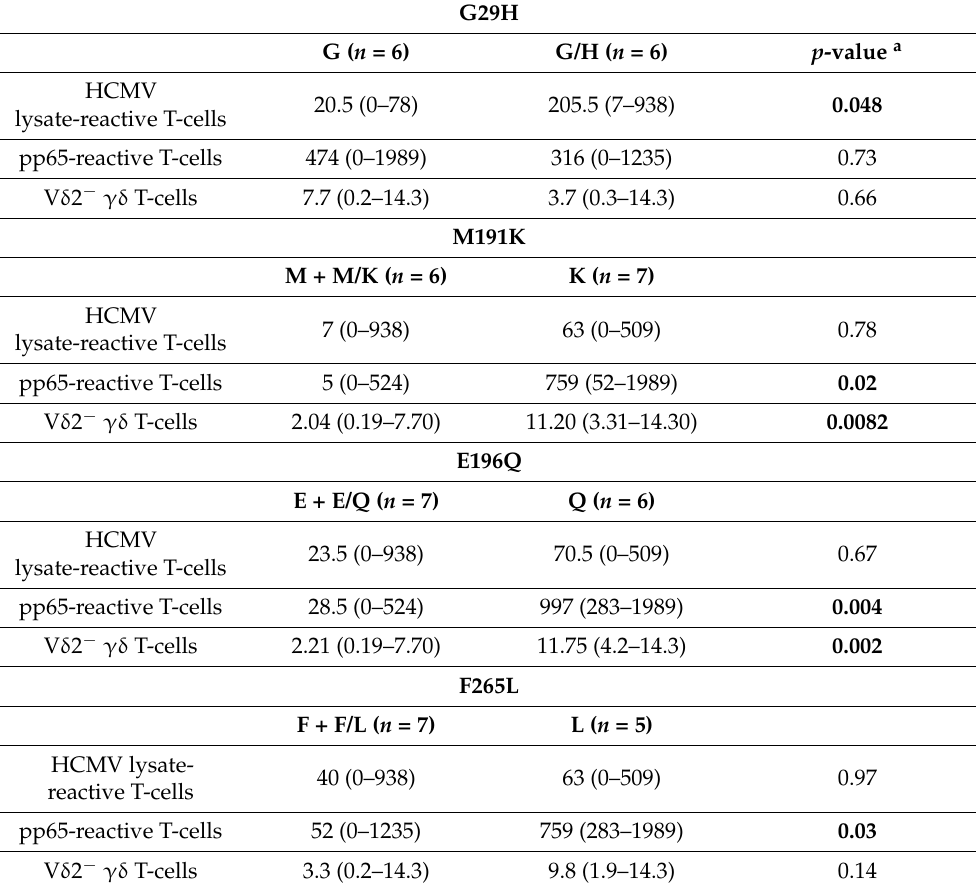
Table 4. UL18 variants are associated with altered HCMV-induced T-cells in